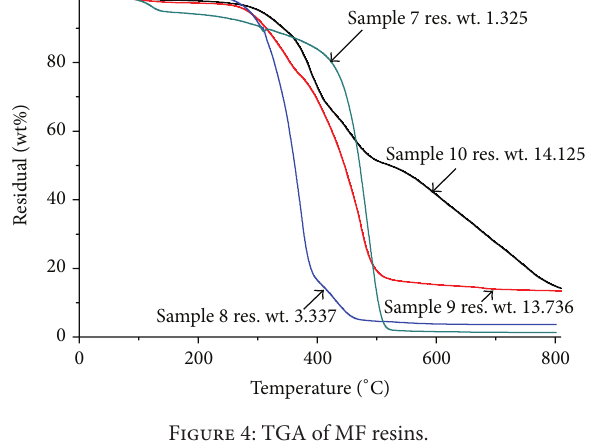
Figure 4: TGA of MF resins.